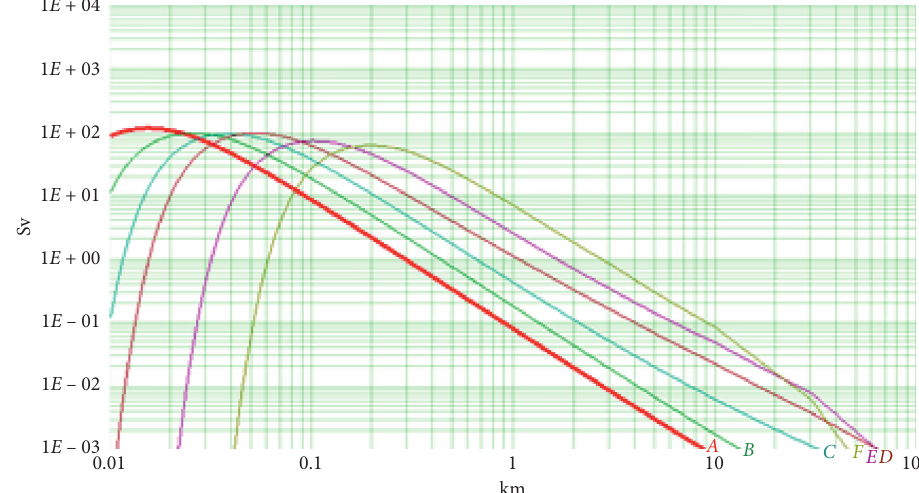
Figure 7: Total effective dose (Sv) as a function of downwind distance (km) from the reactor, for different weather stability classes ( A – F